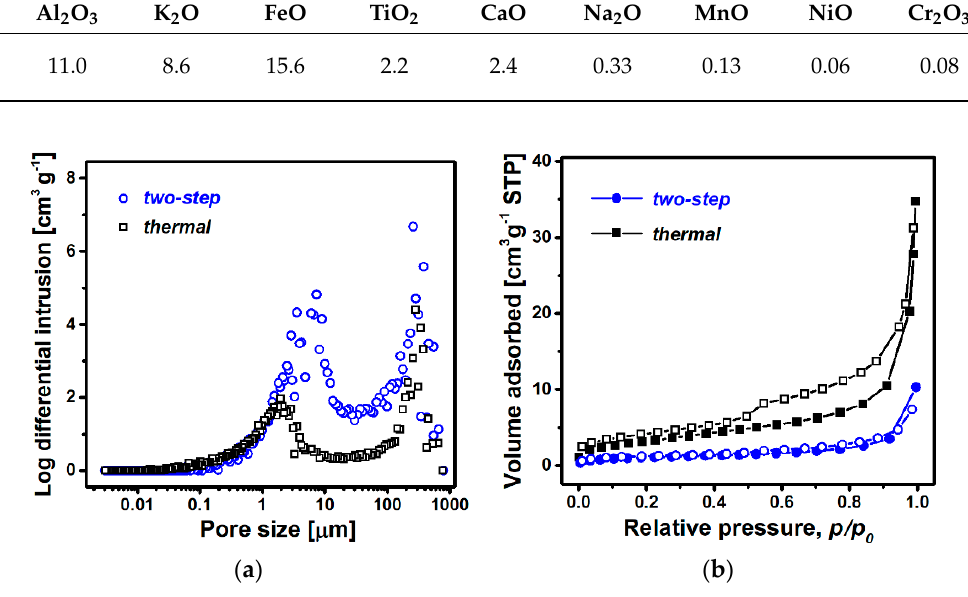
Figure 5. Pore-size distributions of the two-step and thermal eVMTs analyzed by ( a ) Hg porosimetry and ( b ) N 2 sorption. Table 2. Chemical compositions of raw Palabora vermiculite analyzed by XRF.